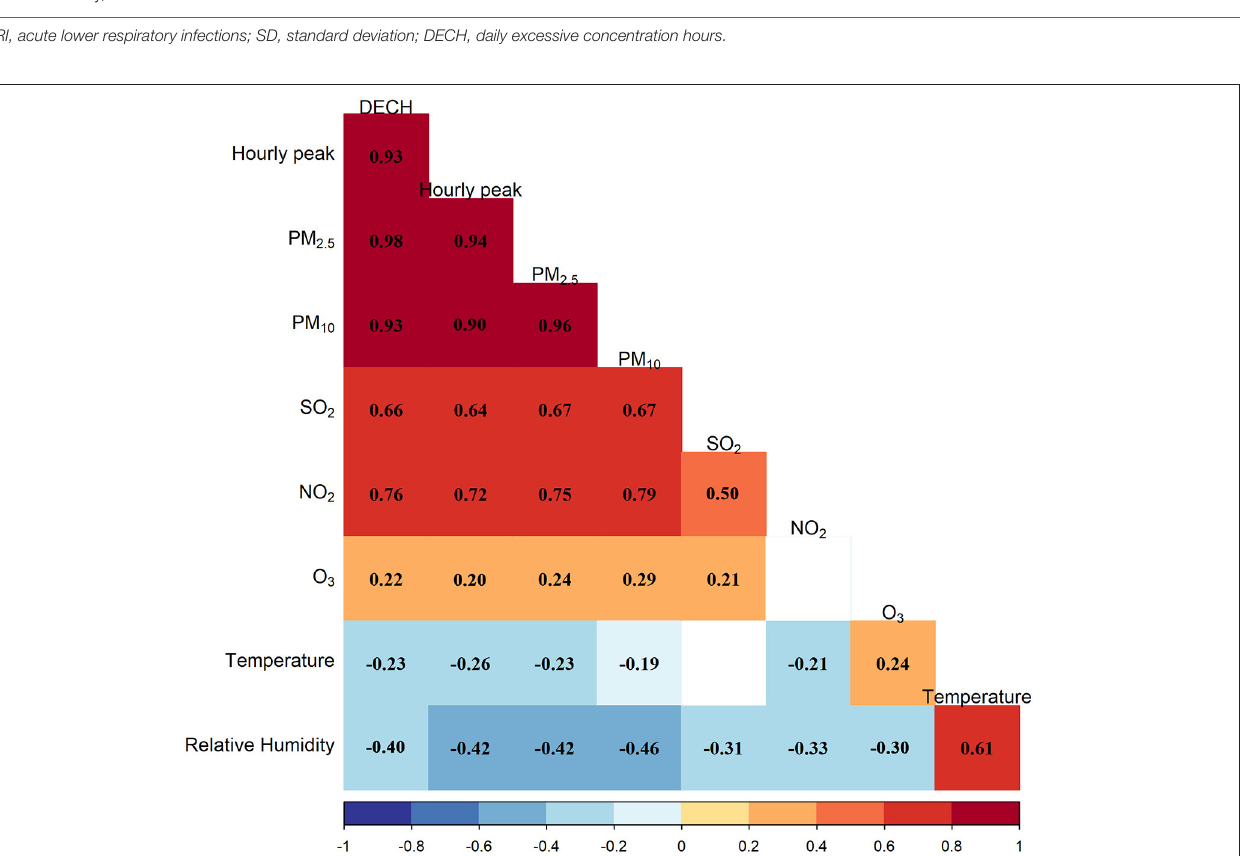
the correlation between independent variables. If the correlation was > 0.80, they were not included in the same two-pollutant